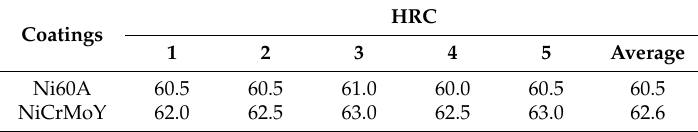
Table 3. Hardness of the Ni60A coating and NiCrMoY coating.